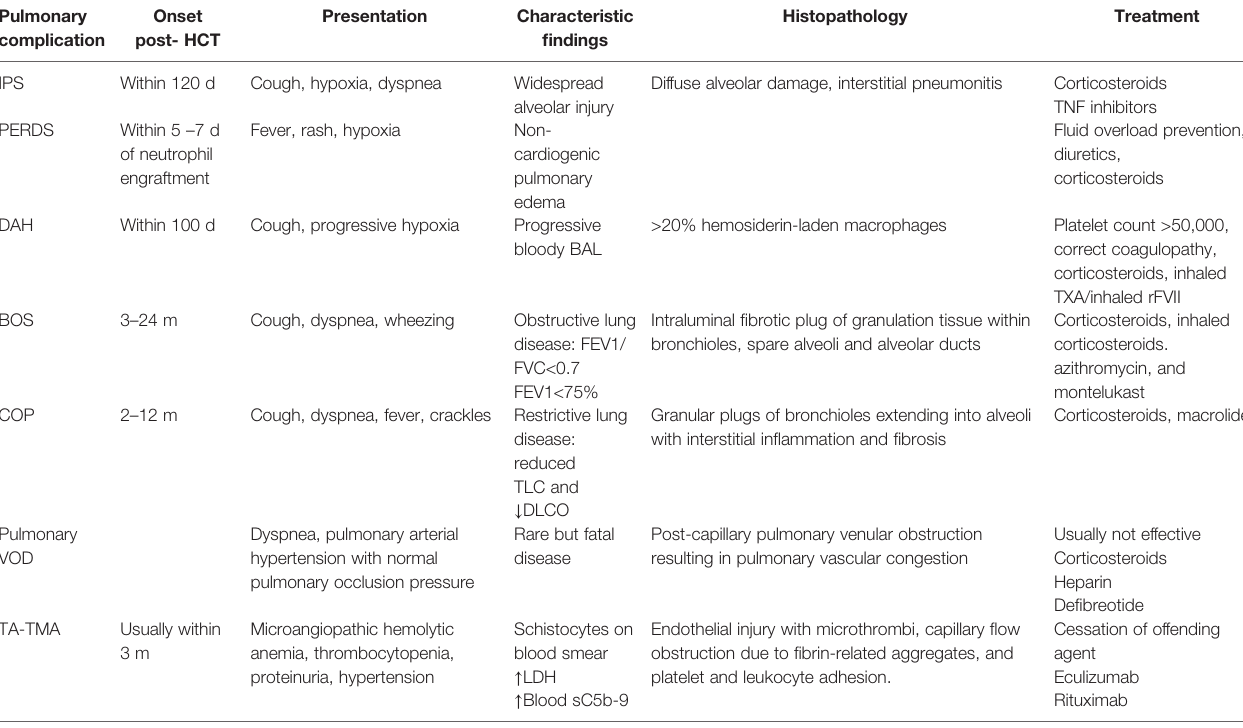
TABLE 1 | Non-infectious pulmonary complications